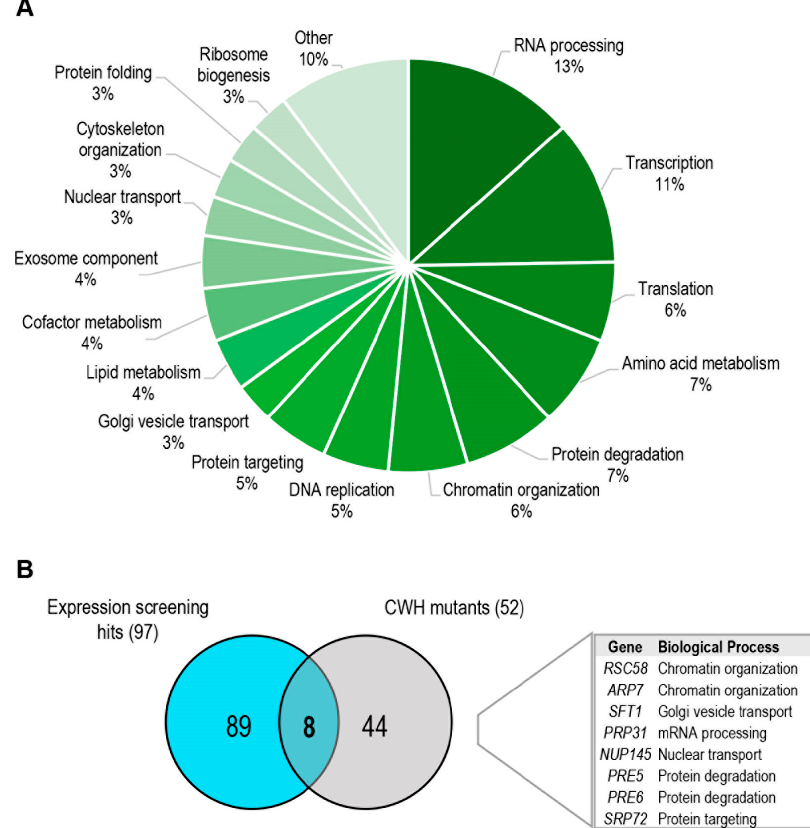
Figure 3. Functional classification of genes identified in the expression screening. ( A ) Relative distribution of functional categories based on Gene Ontology (biological process) from the 97 positive hits. ( B ) The common group of essential gene mutants uncovered in both the phenotypic and expression screenings are shown. CWH: Calcofluor white hypersensitive.